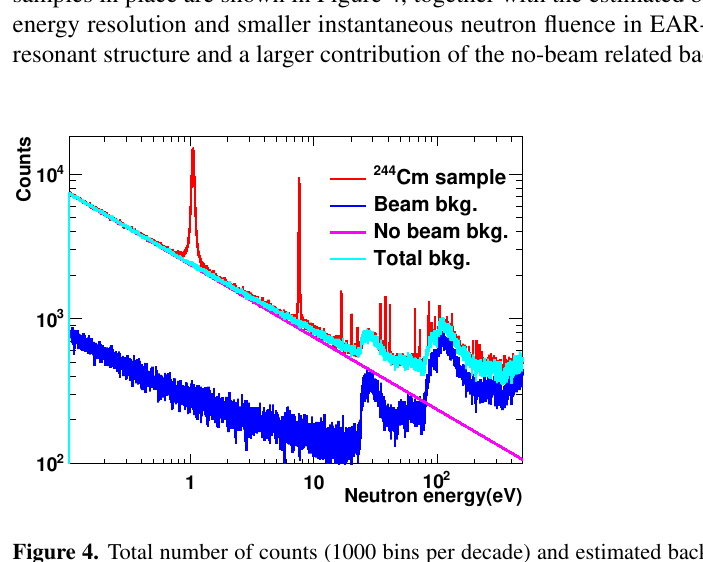
Figure 4. Total number of counts (1000 bins per decade) and estimated backgrounds registered in the 244 Cm EAR-1